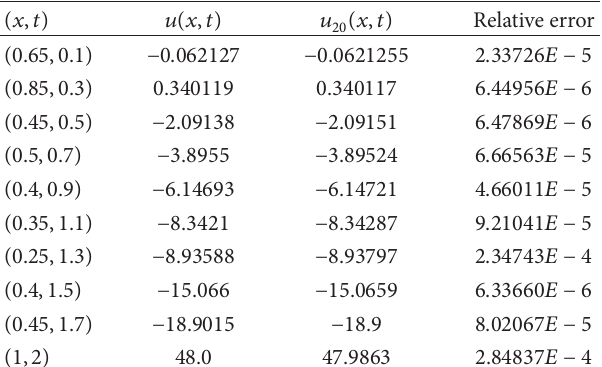
Table 1: Numerical results for Example